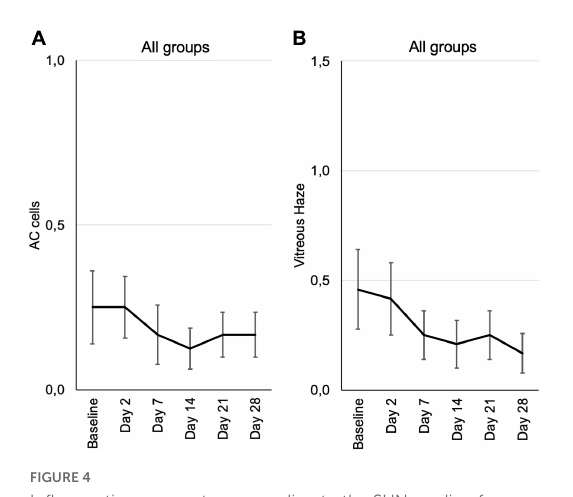
FIGURE4 Inflammation parameters according to the SUN grading from baseline until the end of the study at day 28, assessed at the respective visits. (A) Cells in the anterior chamber (AC cells). (B) Vitreous haze. Mean grading score of AC cells ± SE (A) and mean vitreous haze scores ± SE (B) are shown for all patients from the three different dosing groups at each visit. According to the SUN grading scheme for AC cells and vitreous haze six grading steps are defined (0+, 0.5+, 1+, 2+, 3+, and 4+) (19,